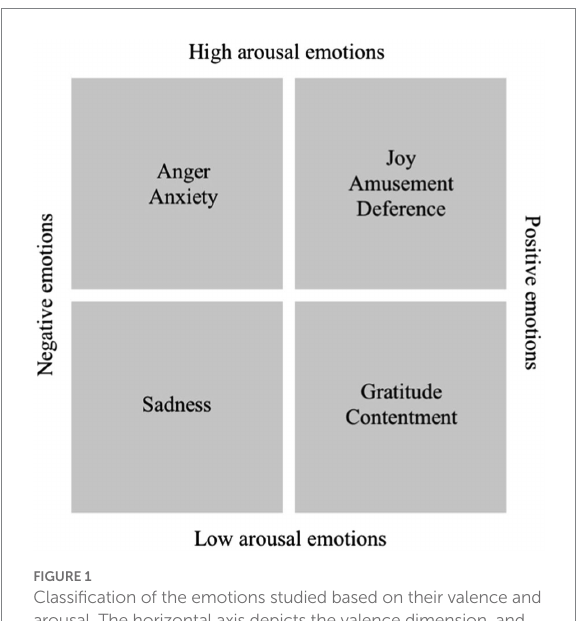
FIGURE 1 Classification of the emotions studied based on their valence and arousal. The horizontal axis depicts the valence dimension, and the vertical axis is the arousal dimension.